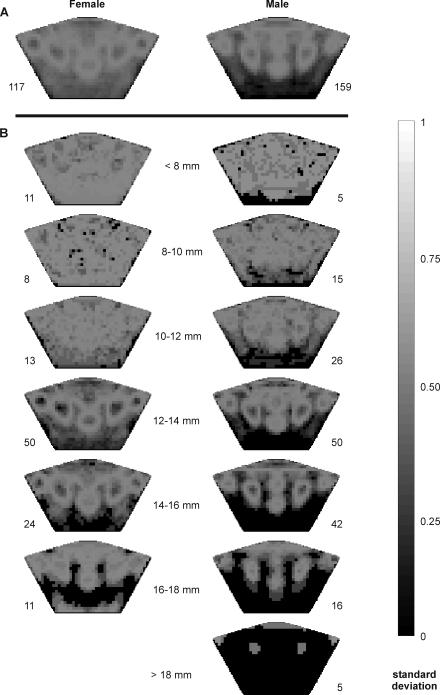
Variation in the probability that any particular area of the carapace is coloured.The standard deviation in the number of males and females in general (a) and in different size classes (b) that are coloured at each point on the carapace. Lighter greys indicate greater variation. The sample sizes are indicated at the base of each image.